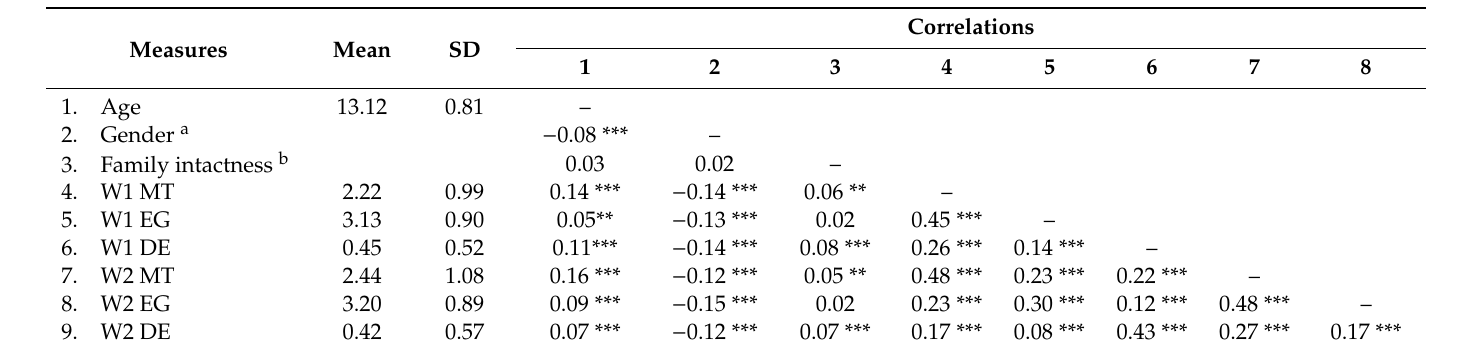
Table 2. Descriptive and correlational analyses.